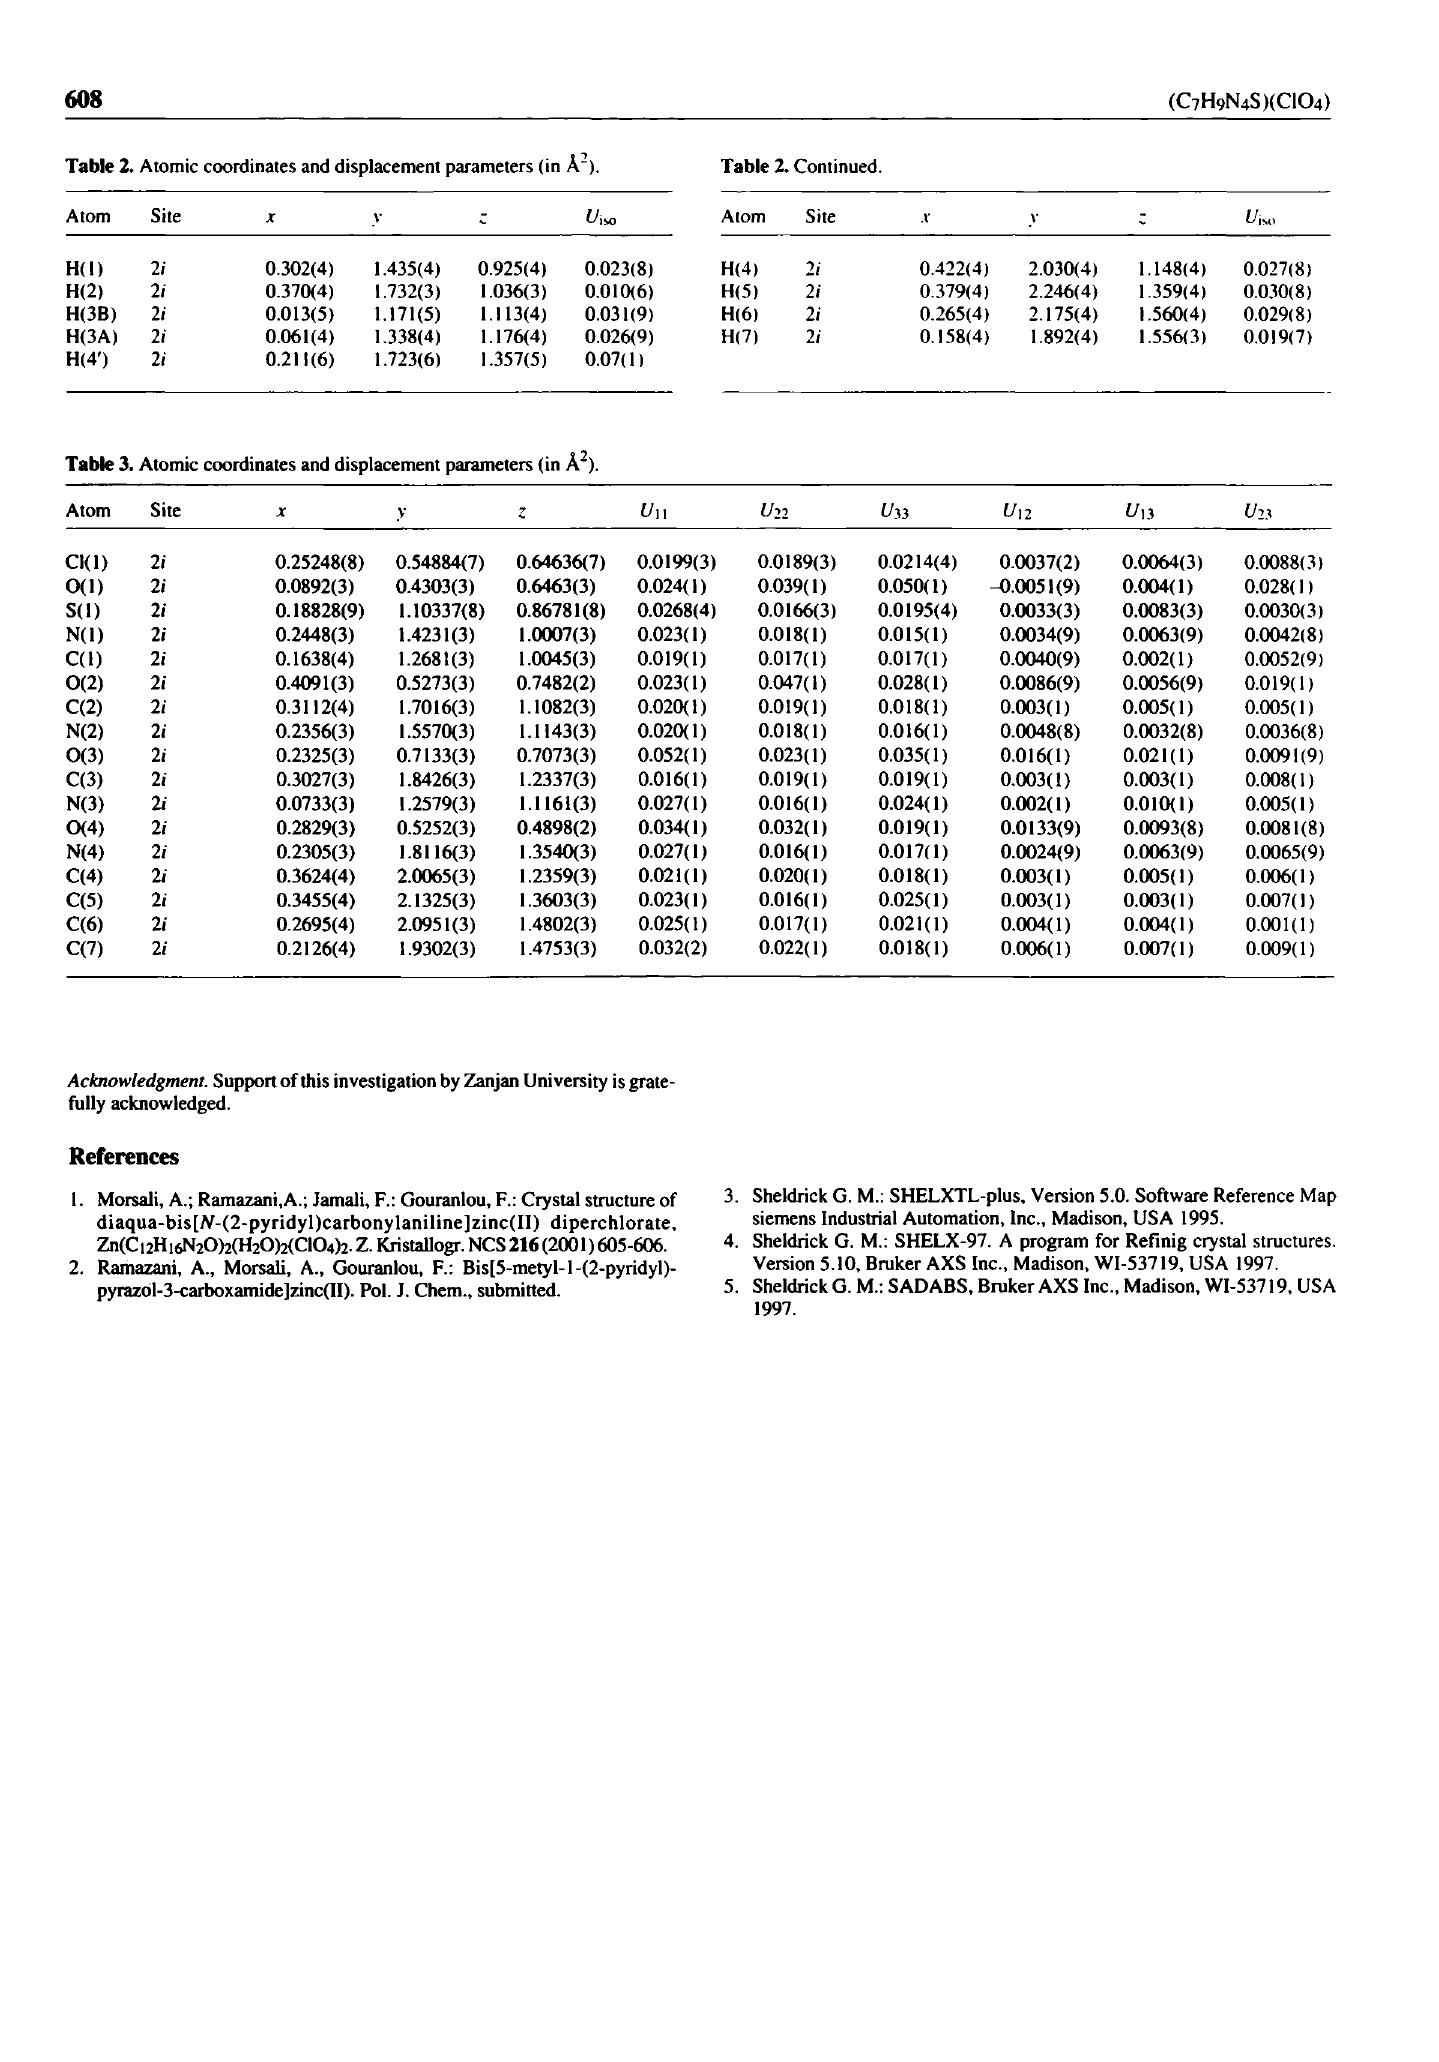
Table 2. Atomic coordinates and displacement parameters (in A 2 ).